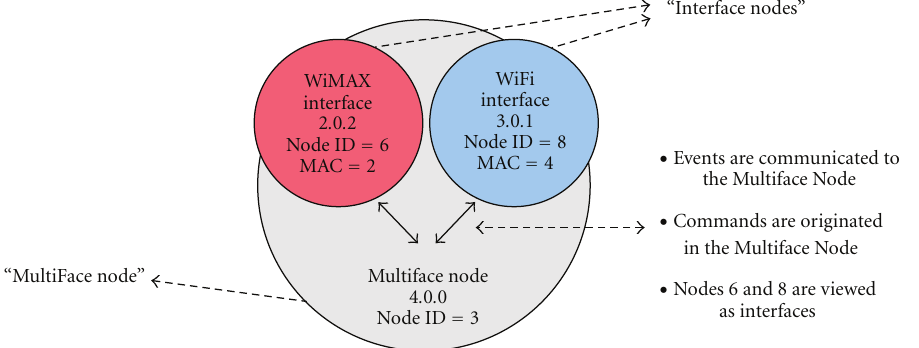
Figure 3: High level overview of a multiFace node.